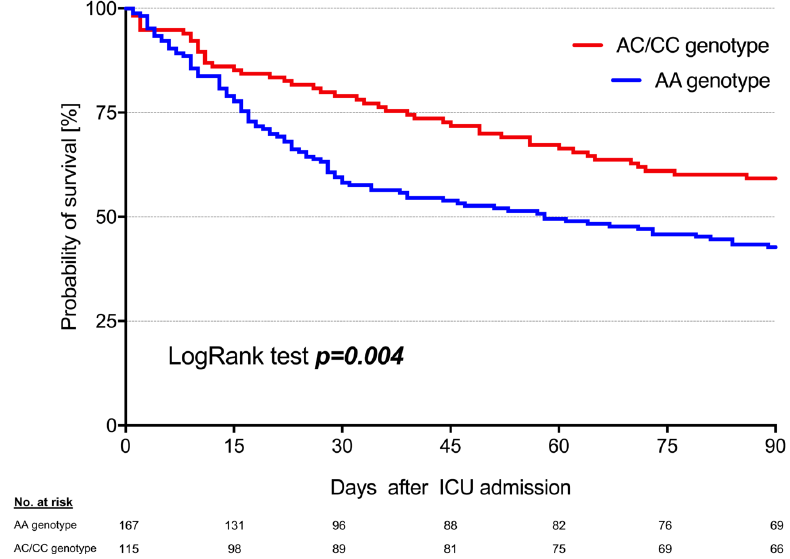
Figure 2. Ninety-day survival in patients with sepsis stratified for their AQP5 -1364 A/C promoter polymorphism. Kaplan–Meier estimates were used to calculate probabilities of 90-day survival based on Aquaporin 5 SNP. Ninety-day survival was higher in C-allele carriers compared with AA genotypes. ICU, intensive care unit.